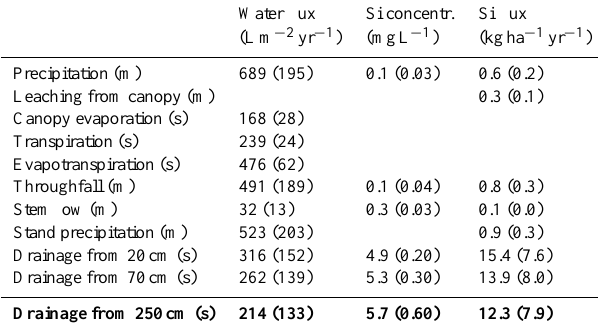
Table 5. Water fluxes, Si concentrations, and Si fluxes in wa- ter (m=measurements, s=simulation); all fluxes are expressed as mean annual values for a four year period (5/2007–4/2011), num- ber in brackets=std.dev ( n =